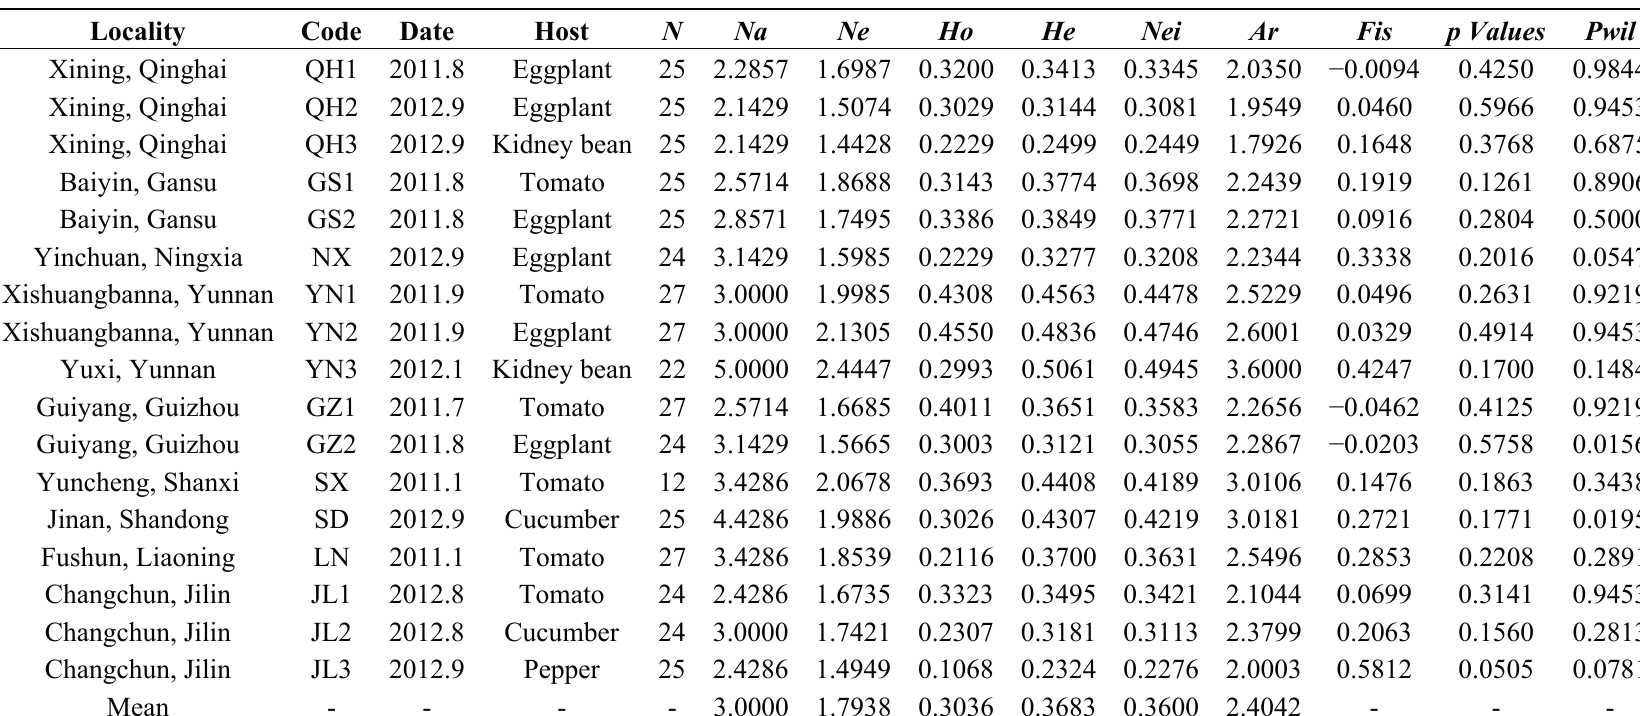
Table 1. Collection sites, population codes, dates of collection, host plants, and genetic diversity indexes for the greenhouse whitefly Trialeurodes vaporariorum populations from China examined in this